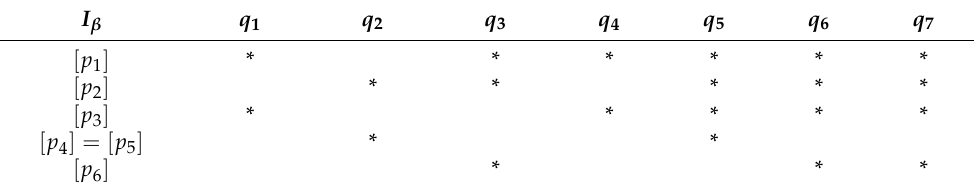
Table 3. A row clarified context.